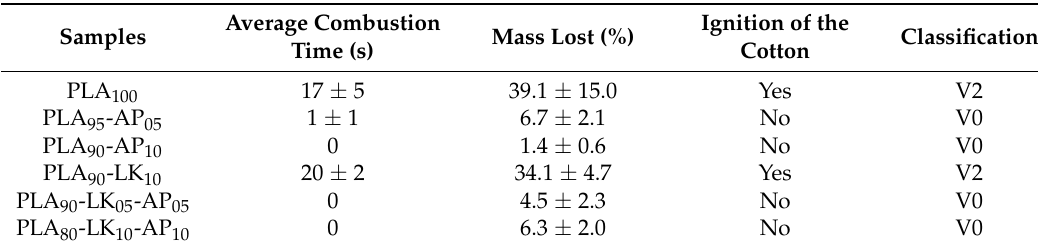
Table 6. Results of UL-94 vertical test.